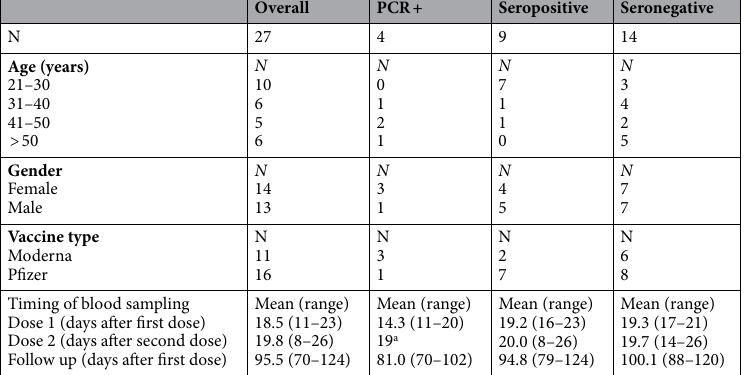
Table 1. Distribution of study participants, overall and by SARS-CoV-2 exposure history. a Three PCR + participants were not vaccinated with dose